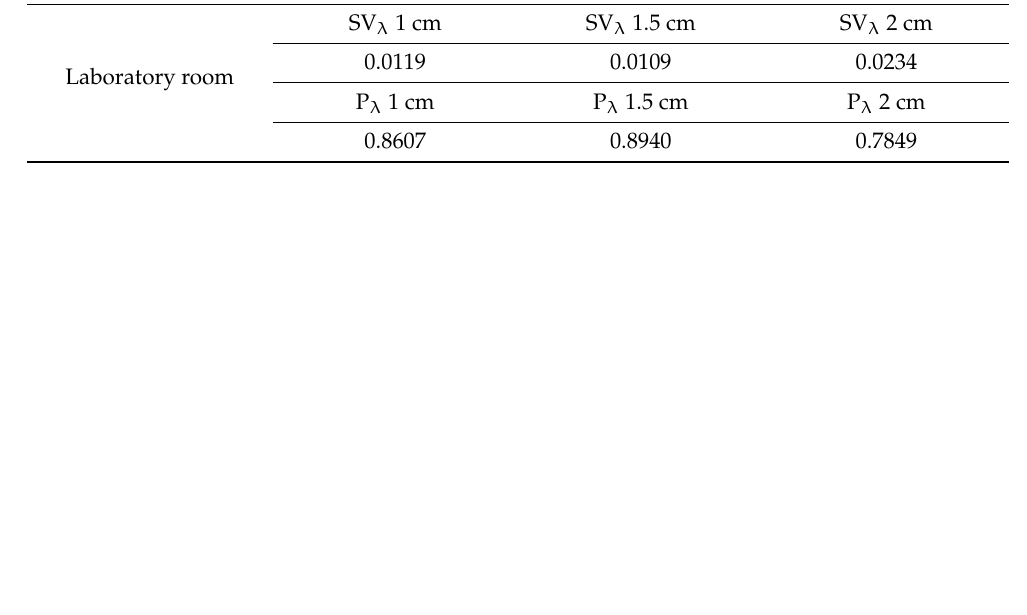
Table 5. Surface variation and planarity values of the point cloud of the lab. room, third case study. Object Figure 12. Sections of the point clouds of the laboratory room; scalar field refers to the planarity value: 1 cm resolution scan ( a ), 1.5 cm resolution scan ( b ), 2 cm resolution scan ( c ).